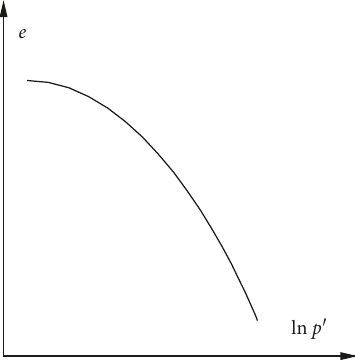
Figure 3: Changing curves of e and ln p